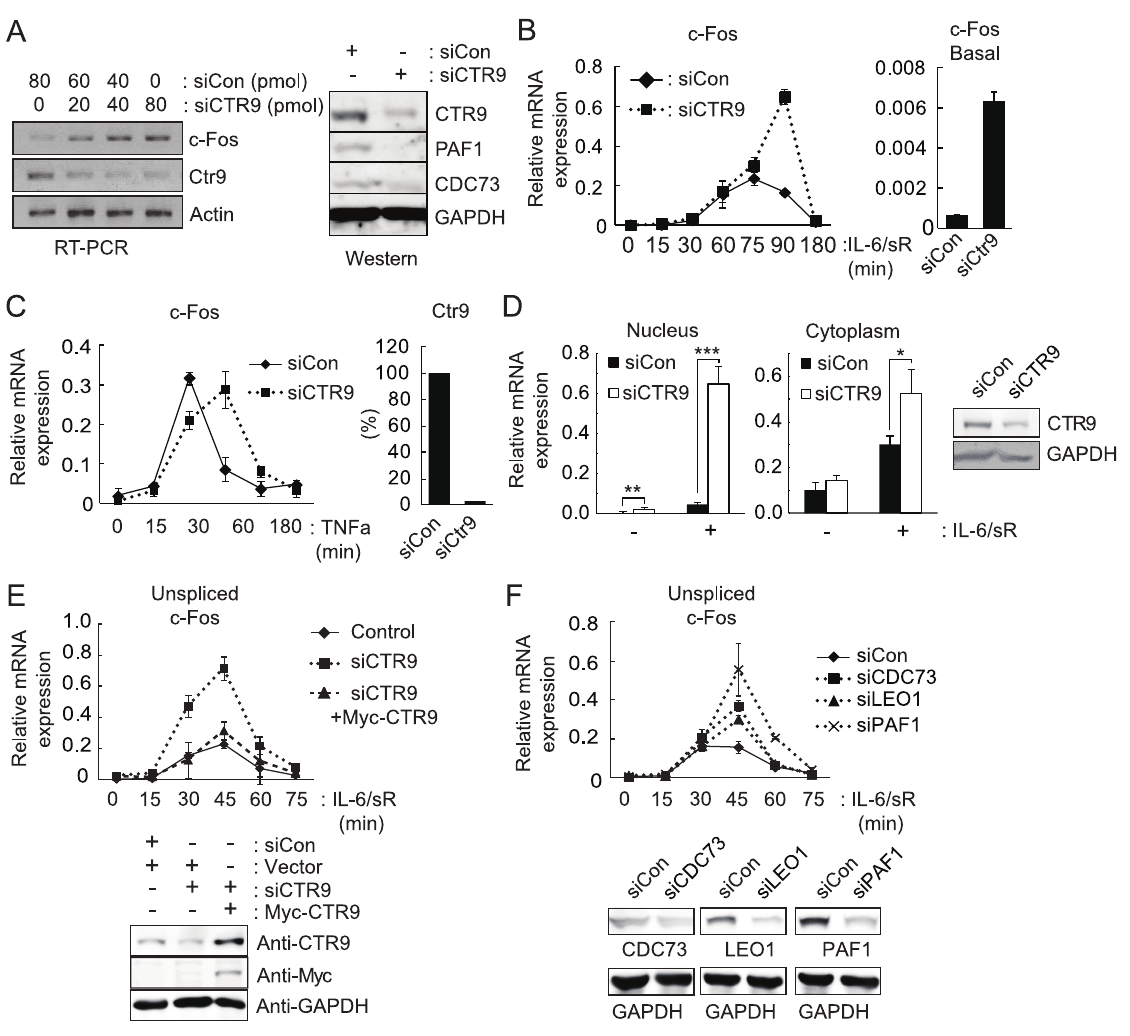
Figure 1. c-Fos transcription is negatively regulated by PAFc in the nucleus. A , Left, transcript levels of c-Fos, Ctr9 and Actin were analyzed by RT-PCR in HepG2 cells transfected with control siRNA (siCon) or CTR9 siRNA (siCTR9), as indicated above. Right, endogenous protein levels of PAFc components in CTR9 knockdown cells were measured by western blot analysis. B , IL-6-induced and basal c-Fos expression was analyzed by Real-time RT-PCR (RT-qPCR). HepG2 cells were transfected with either control or CTR9 siRNA. Approximately 48 hours later, cells were treated with IL-6 plus IL- 6sR (20 ng/ml each) for the indicated length of time. Expression levels were normalized to b -Actin. C , Cells were transfected with Control or CTR9 siRNA. 48 hours later, cells were treated with TNF a (20 ng/ml) for the indicated length of time. D , Left, Nuclear and cytoplasmic RNA were prepared using the PARIS kit. The levels of c-Fos mRNA in the nuclear and cytoplasmic fractions were then analyzed by RT-qPCR. Right, endogenous protein levels of CTR9 in control and knockdown cells were measured by western blot analysis. E , Cells were transfected as indicated. 48 hours later, cells were treated with IL-6 plus IL-6sR (20 ng/ml each) for the indicated length of time. The unspliced c-Fos transcripts were analyzed by RT-qPCR. Bottom, endogenous protein levels of CTR9 and exogenous Myc-CTR9 were measured by western blot analysis. F , PAFc components were individually knocked down by transient siRNA transfection. Samples were prepared and analyzed as described in E . Bottom, endogenous protein levels of PAFc components were measured by western blot analysis. **p , 0.01, ***p , 0.001 by Student’s t test. Error bars represents standard deviation(SD) (n=3).